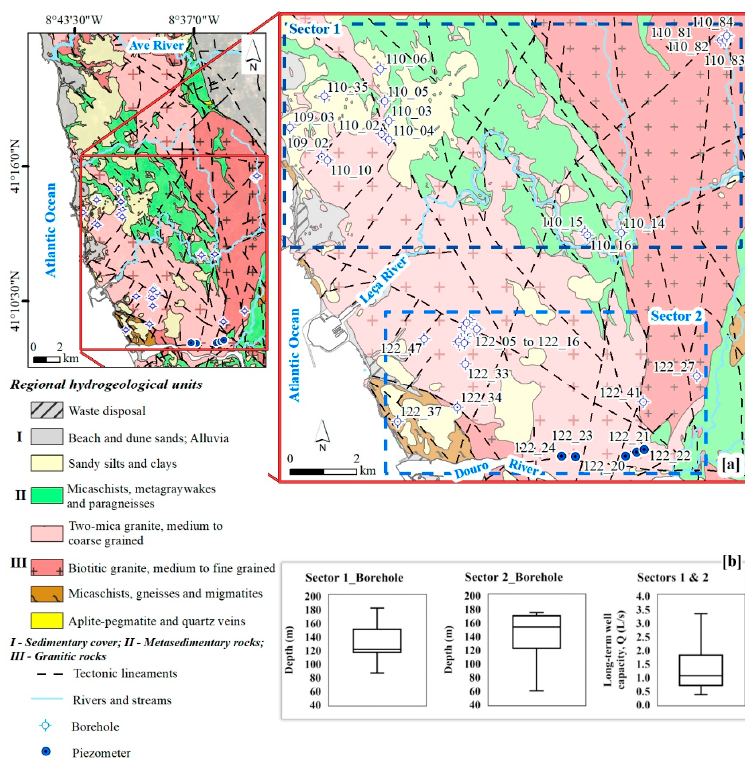
Figure 4. Inventory of boreholes and piezometers used for the hydrodynamical assessment. ( a ) Study sites (Sectors 1 and 2) are shown on the right side of the figure; ( b ) Depth of boreholes and long-term well capacity for Sectors 1 and 2.